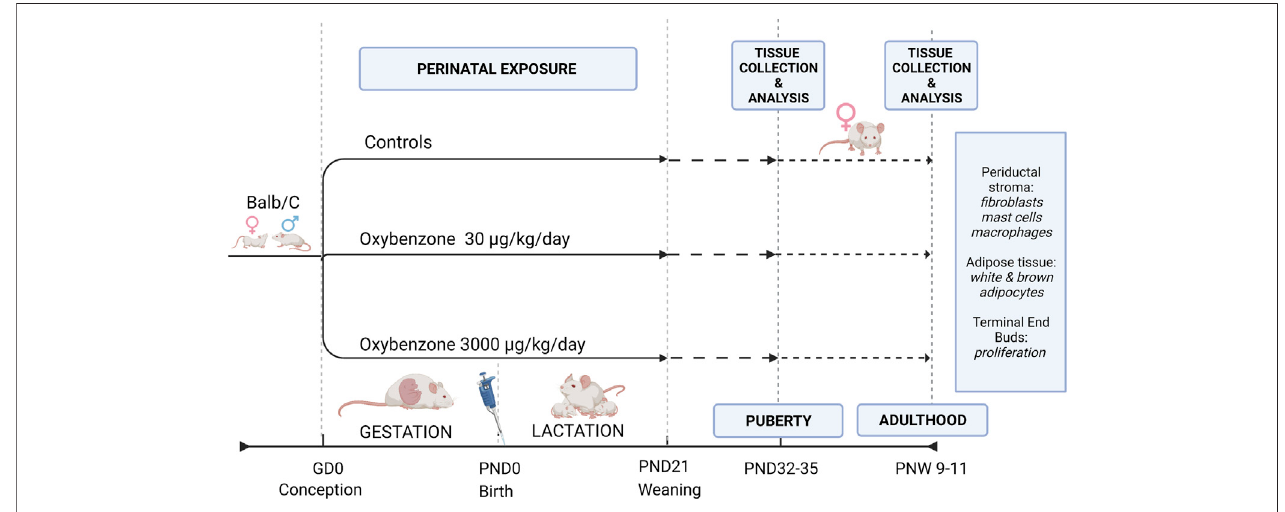
FIGURE 1 | Study Design illustrating the exposure and evaluation periods. GD, gestational day; PND, postnatal day; PNW, postnatal